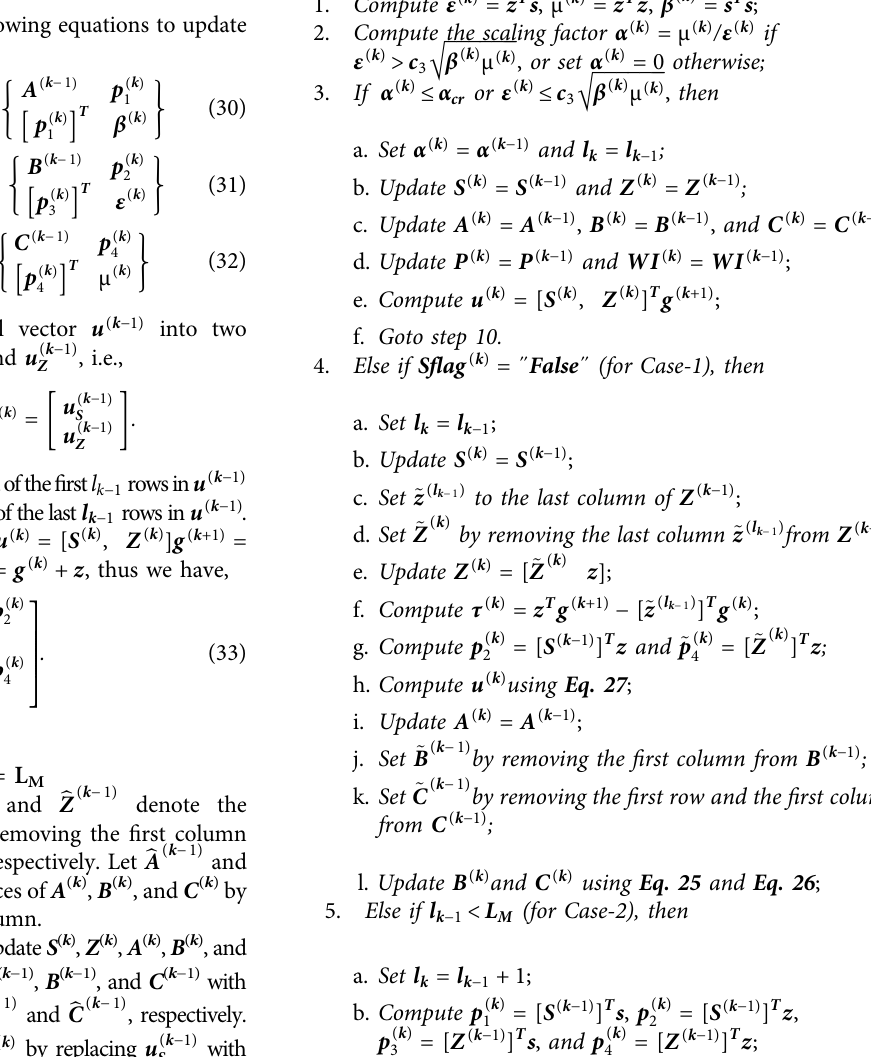
Algorithm-4: Updating Matrices and Vectors Used for Solving the L-BFGS